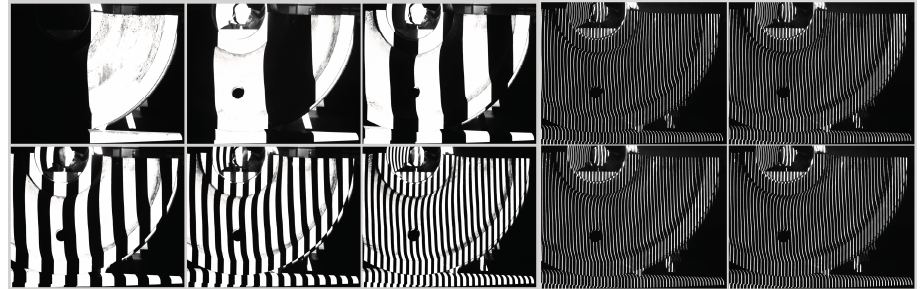
Figure 12. Coded image and light strip image captured by 3D scanning sensor at the second